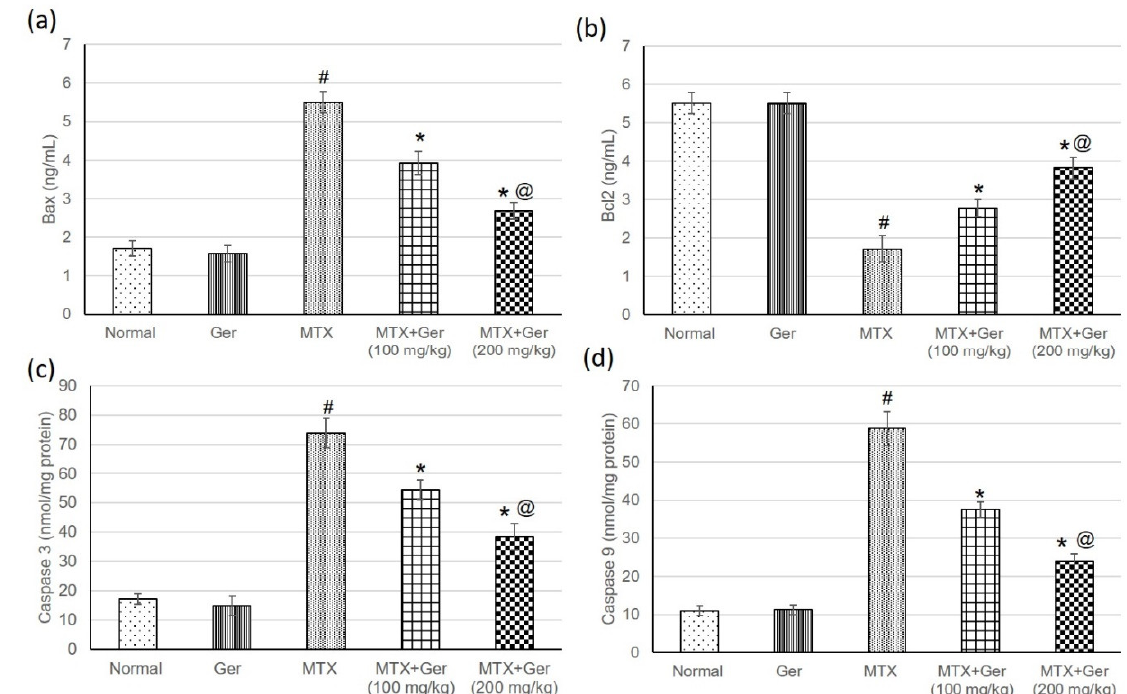
Figure 6. Effects of treatment with Ger (100 and 200 mg/kg) for 19 days on the apoptotic markers including ( a ) Bax, ( b ) Bcl2, ( c ) caspase-3 and ( d ) caspase-9 in MTX-induced AKI in rats ( n = 6). All values are expressed as mean ± SD. #, statistically significant from normal group; *, statistically significant from MTX-only group; @, statistically significant from MTX + Ger 100 mg/kg group ( p < 0.05) using one-way ANOVA followed by Tukey’s post hoc analysis.